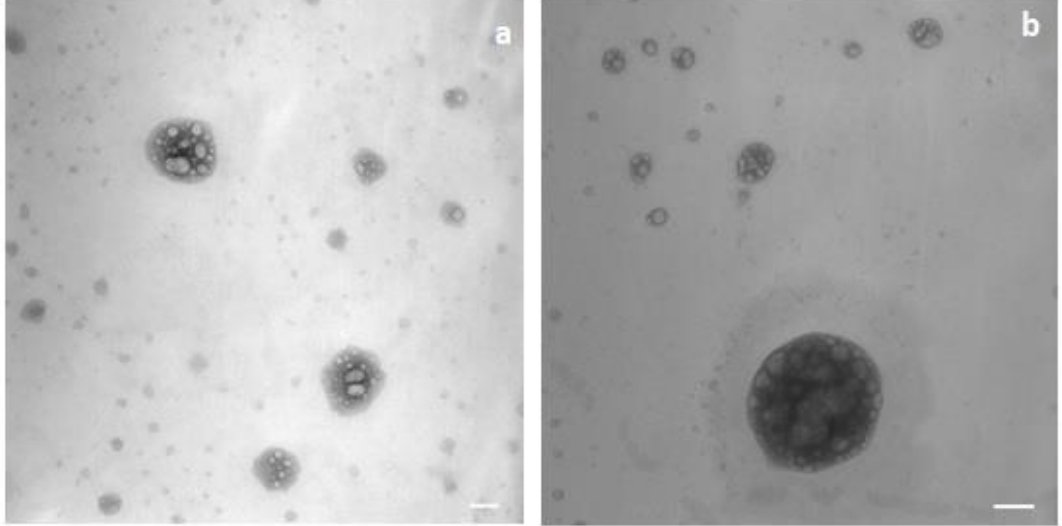
Figure 5. TEM image of the sample obtained from Test 1 ( a ) and Test 2 ( b ) (magnification 39,000, scale bar 150 nm).